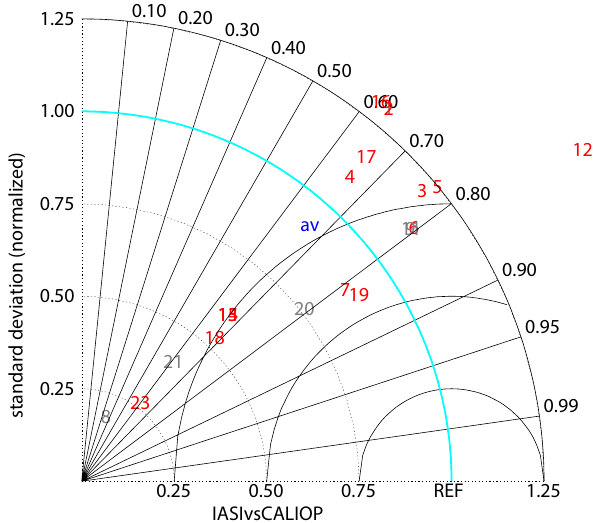
Figure 6. Taylor diagram (normalized) for IASI and CALIOP al- titude over oceanic regions. Sites are identified by their number in Table 4. The overall statistics appear in blue (“av” for